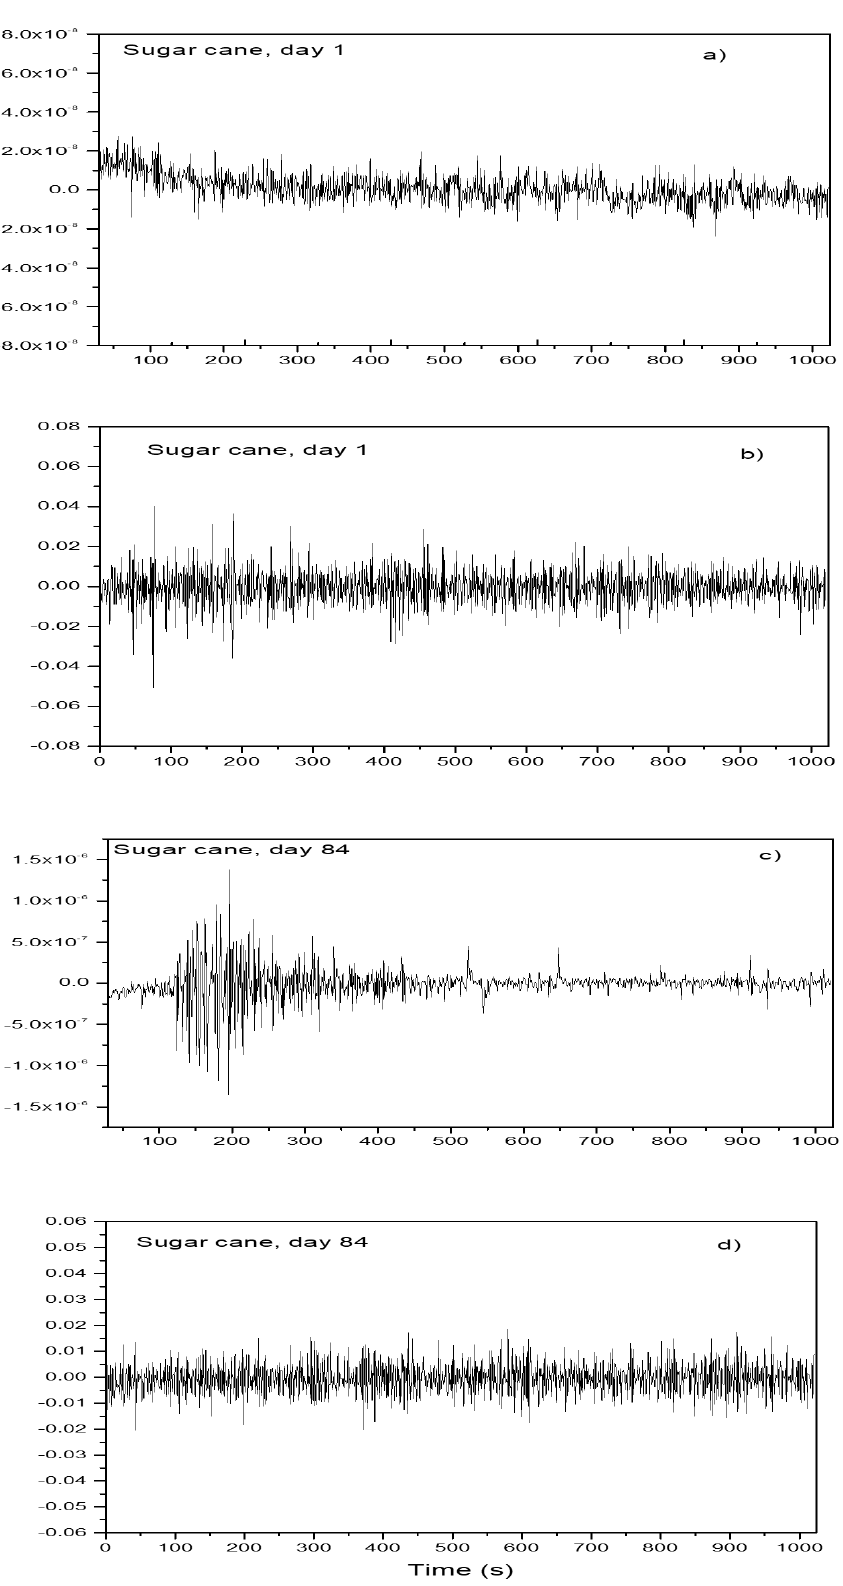
Figure 4. Noise in current and in potential for Al in the blend containing ethanol obtained from sugar cane after (( a ) and ( b )) 1 day and (( c ) and ( d )) 84 days of exposure.